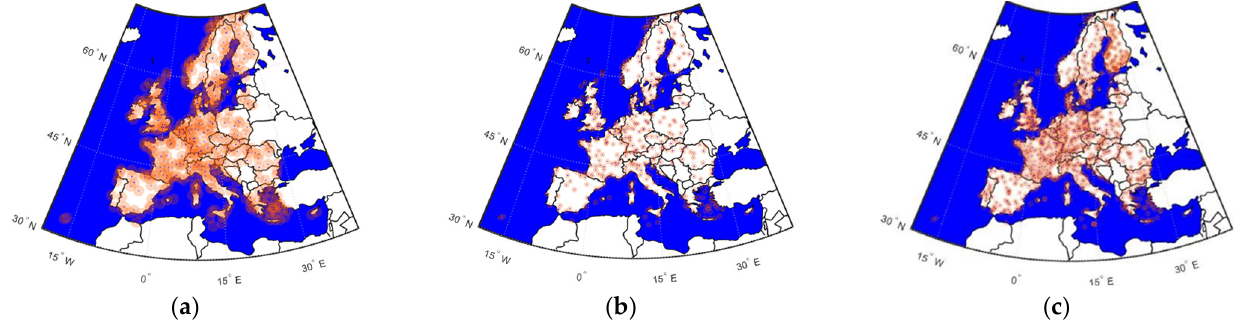
Figure 3. Coverage area of European commercial airports with an assumed catchment radius of ( a ) 100 km, ( b ) 50 km, and ( c ) 50 km considering all airfields of at least 1000 m runway.